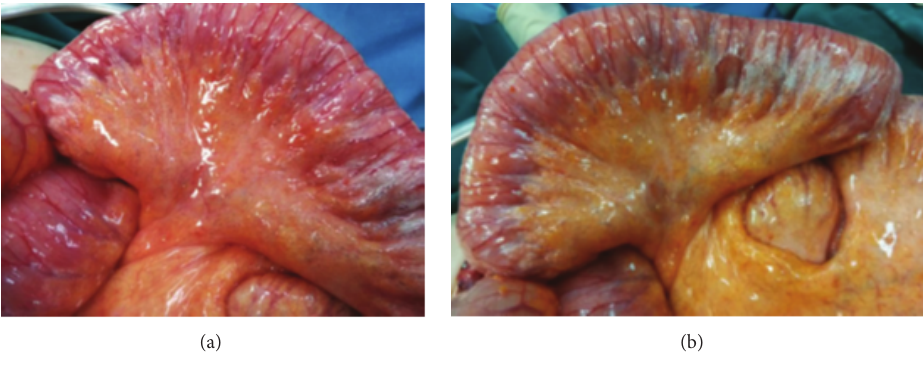
Figure 2: Intraoperative images of pneumatosis